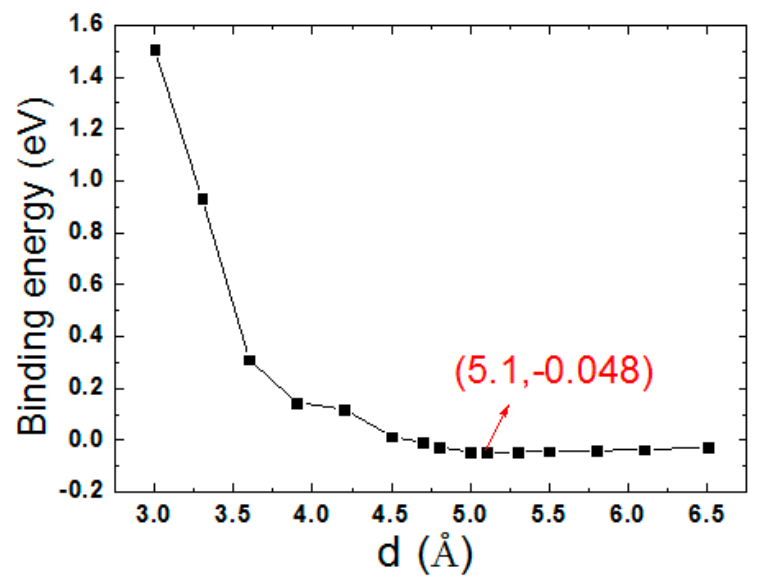
Figure 3. (Color online) Binding energy of the SiC / GeC bilayer as a function of the interlayer distance.